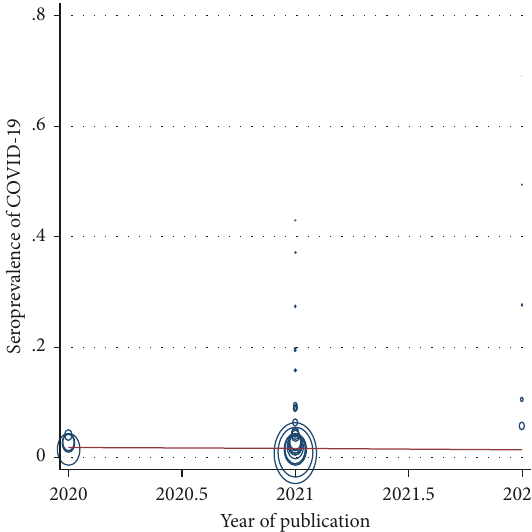
Figure 4: Meta-regression of the relationship between the sero- prevalence of COVID-19 in blood donors and the year of